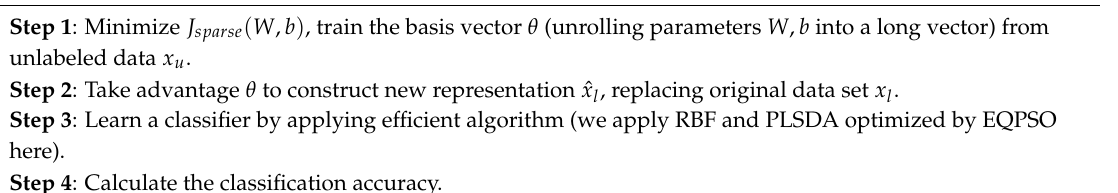
Algorithm 1. Self-taught learning algorithm